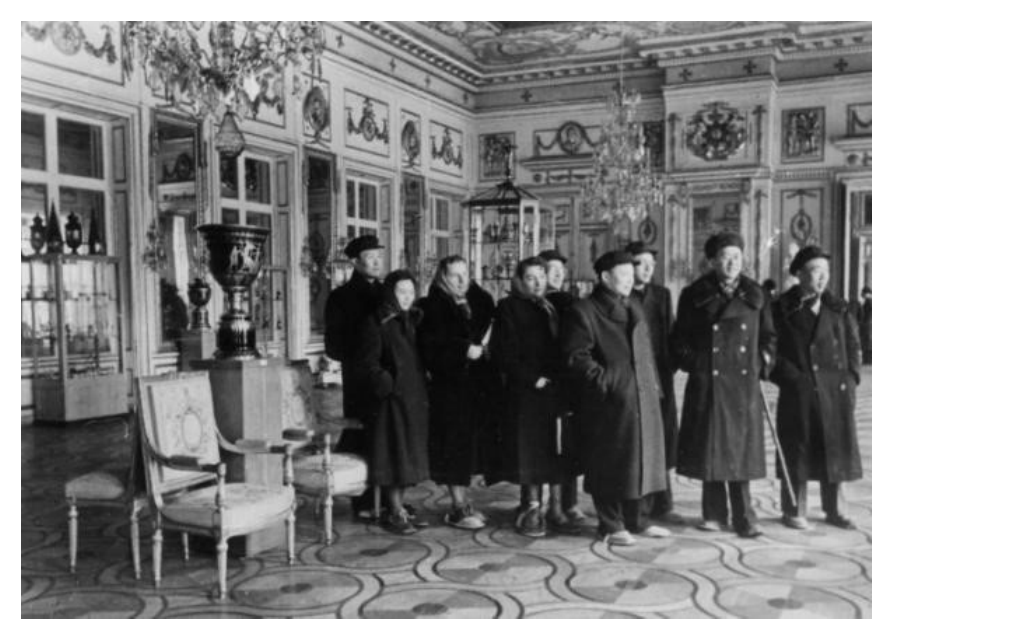
Figure 5. Jeou-jang Jaw (first row, starting from the right) with Luogeng Hua and Sanqiang Qian as the members of Chinese delegation visited the former Soviet Union in 1953. (Source: commemorative volume on Jeou-jang Jaw’s 100th birthday; edited by the National Space Center, CAS,